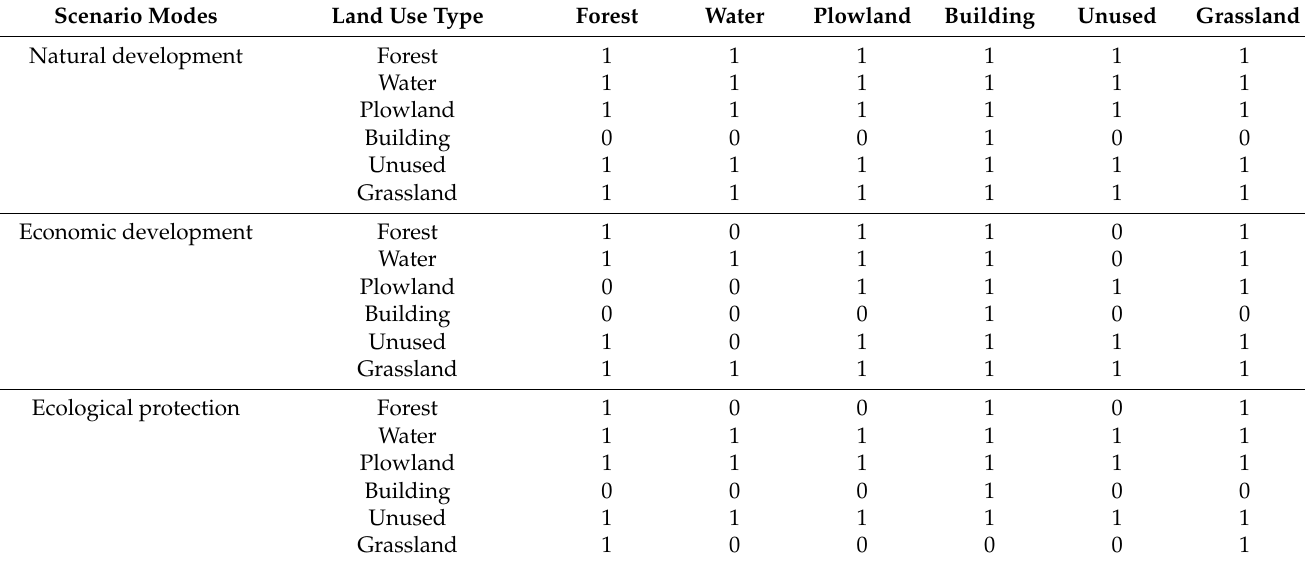
Table 2. Land use transfer cost matrix under different